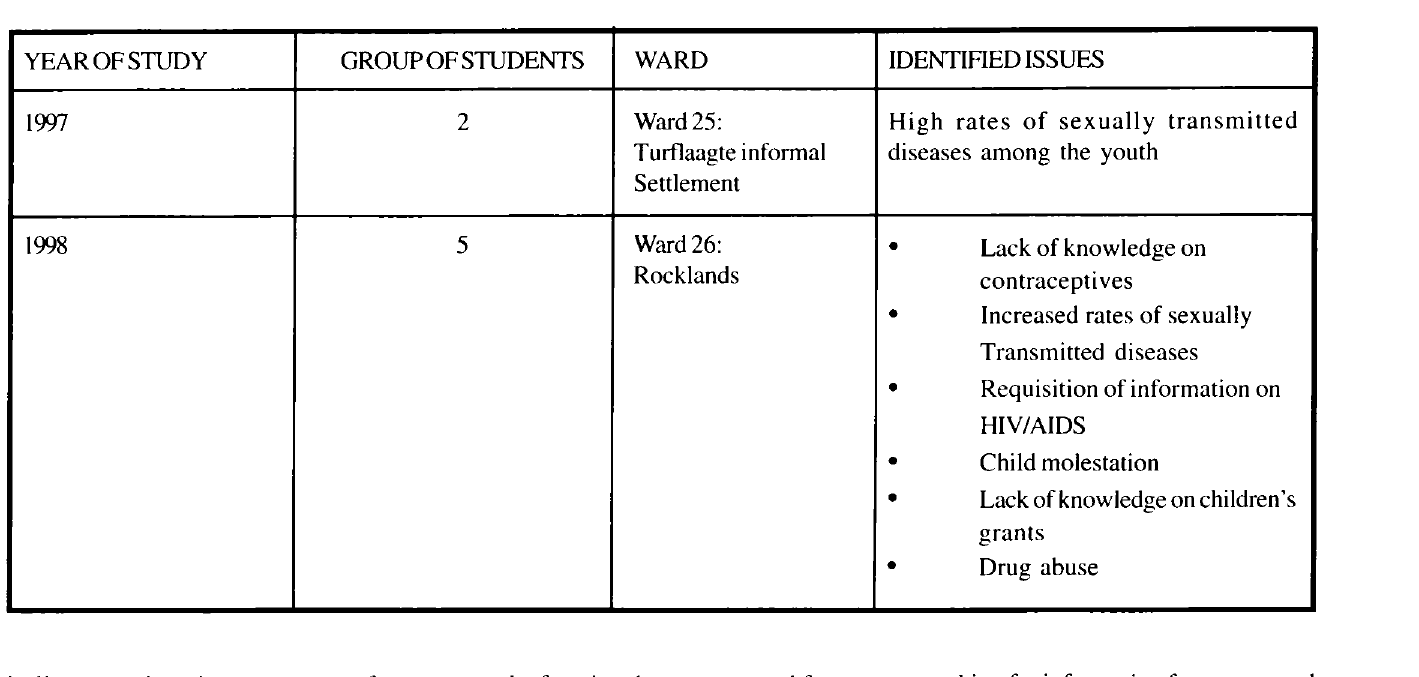
Table 1: Community needs identified by first year nursing students in Mangaung